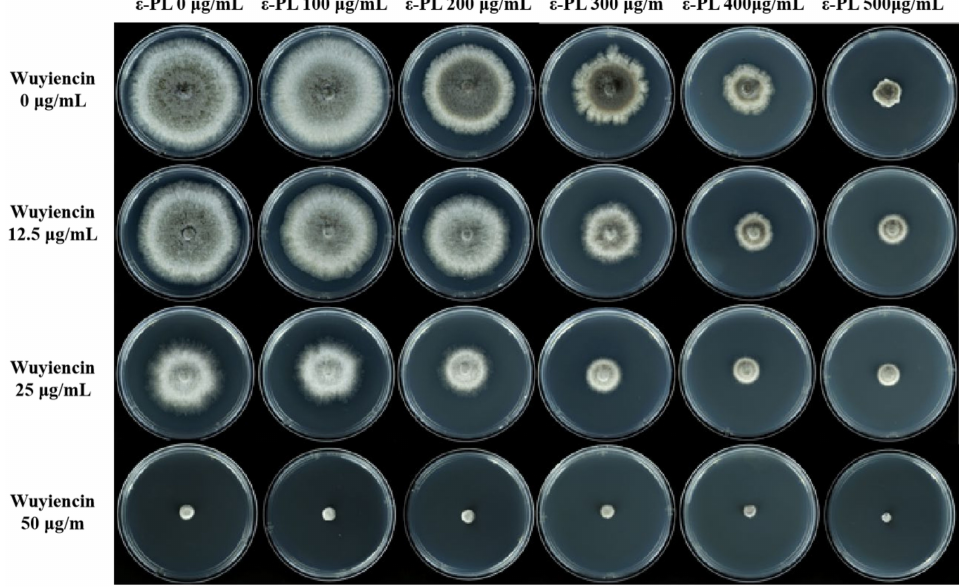
Figure 2. Inhibitory effect of different concentrations of wuyiencin + ε -PL on the mycelial growth of Botrytis cinerea .